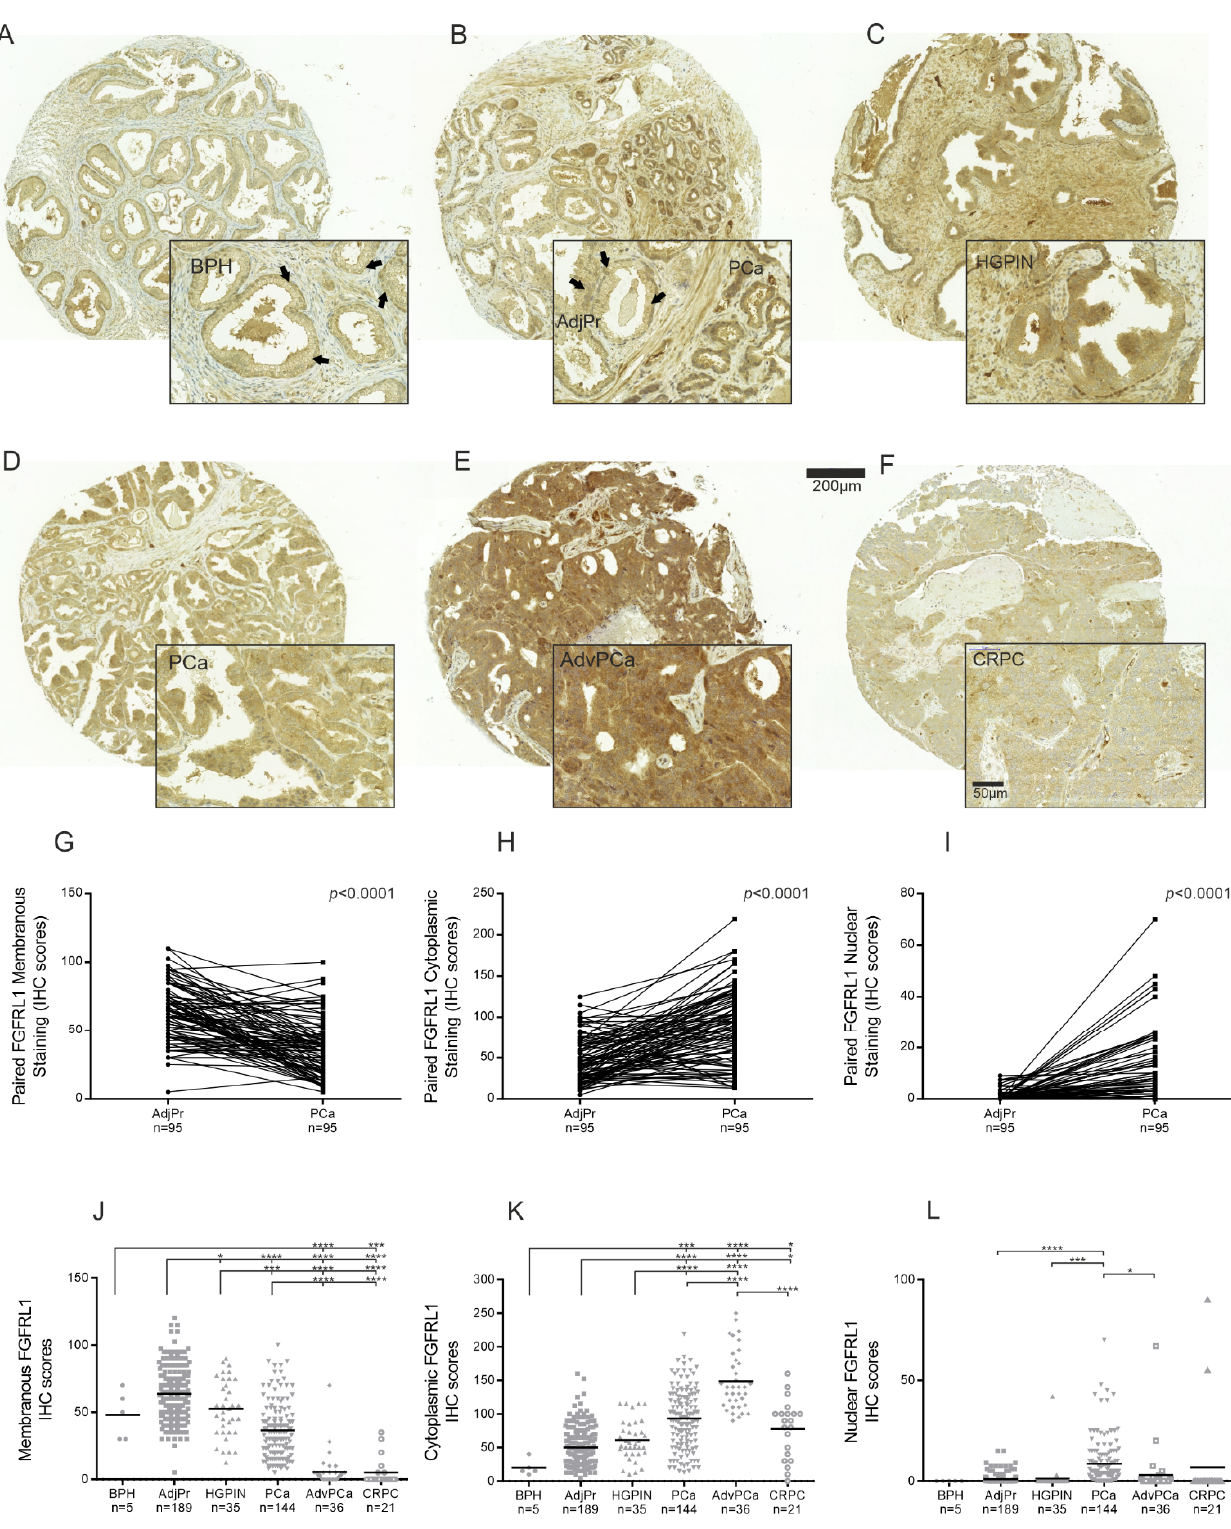
Figure 1. Immunohistochemical (IHC) staining of FGFRL1 in benign prostate and PCa tissue. ( A – F ), Representative FGFRL1 IHC staining is shown in benign prostate hyperplasia (BPH) ( A ), adjacent benign prostate tissue (AdjPr) ( B ), high-grade PIN (HGPIN) ( C ), primary PCa ( B , D ), advanced PCa (AdvPCa) ( E ), and castration-resistant PCa (CRPC) ( F ). The arrows point to representative areas with clear membranous FGFRL1 staining ( A , B , inserts). ( G – I ), Comparison of cell membrane ( G ), cytoplasmic ( H ), and nuclear ( I ) FGFRL1 IHC scores in paired specimens in TMA I. ( J – L ), Comparison of cell membrane ( J ), cytoplasmic ( K ) and nuclear ( L ), FGFRL1 IHC scores